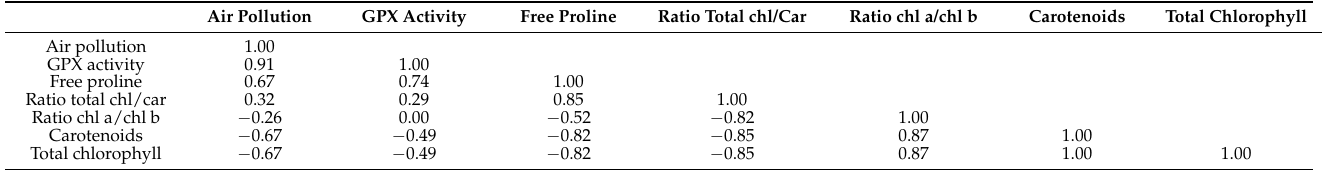
Table 4. Pearson correlations between the level of air pollution and levels of studied biochemical markers in leaves of T. tomentosa from four experimental plots (n = 72, 3 individuals × 4 plots × 6 years).